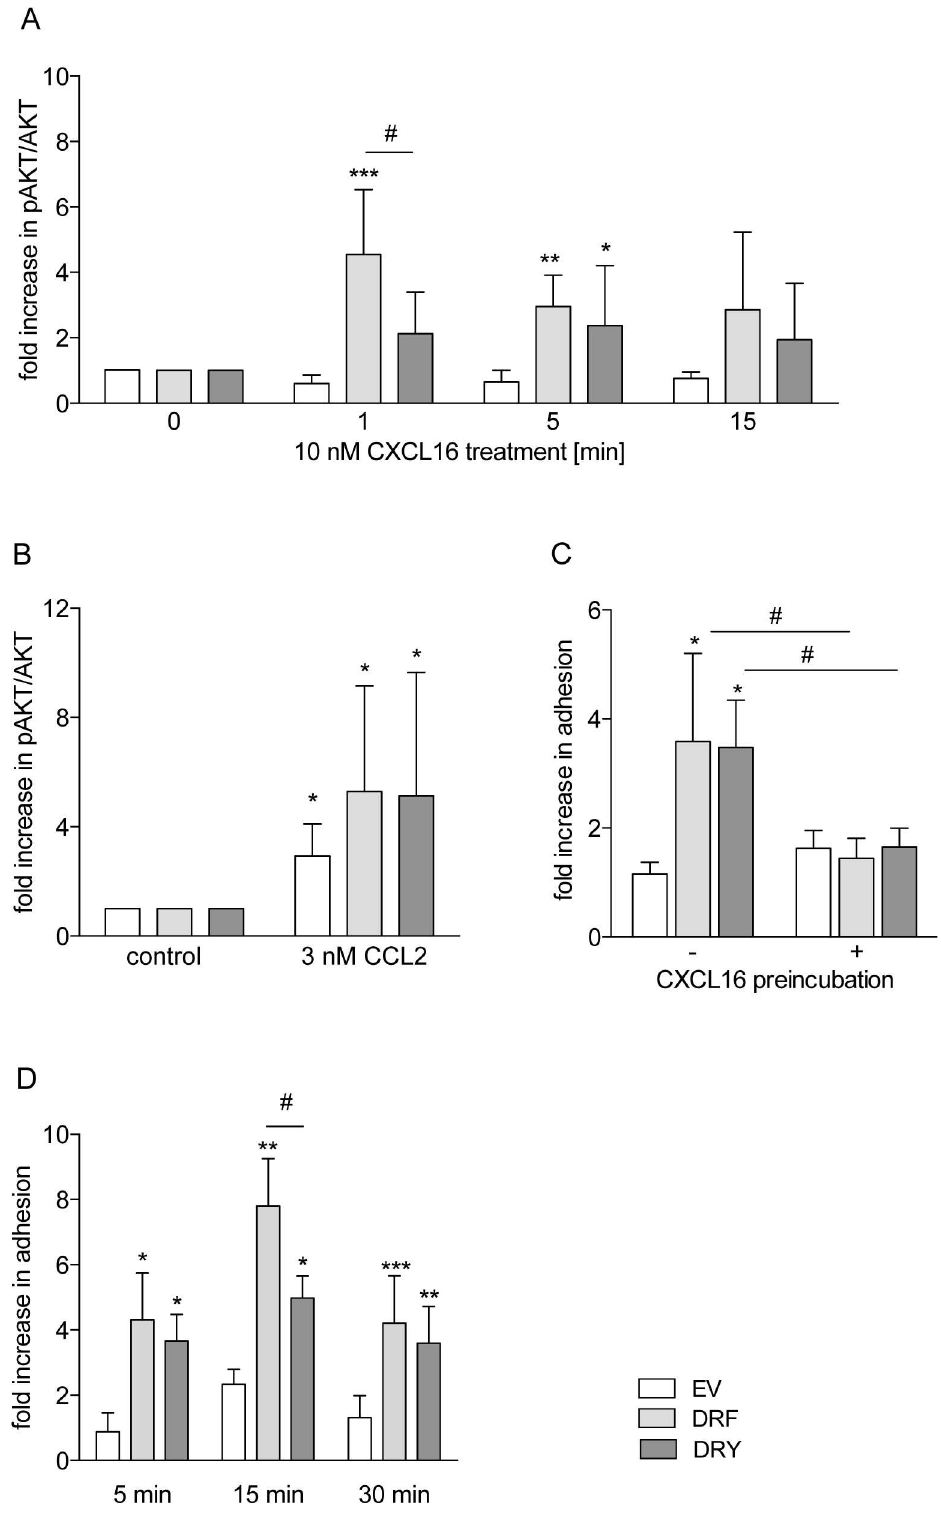
Fig 4. Rescue of the DRY motif in CXCR6 has no major impact on AKT signaling and adhesion. THP-1 cells were transduced with lentivirusencodinghumanCXCR6 variants or EV control. A/B: AKT activation upon stimulationwith 10 nM solubleCXCL16(A, n = 7) or with 3 nM CCL2 (B, 10 min, control of general